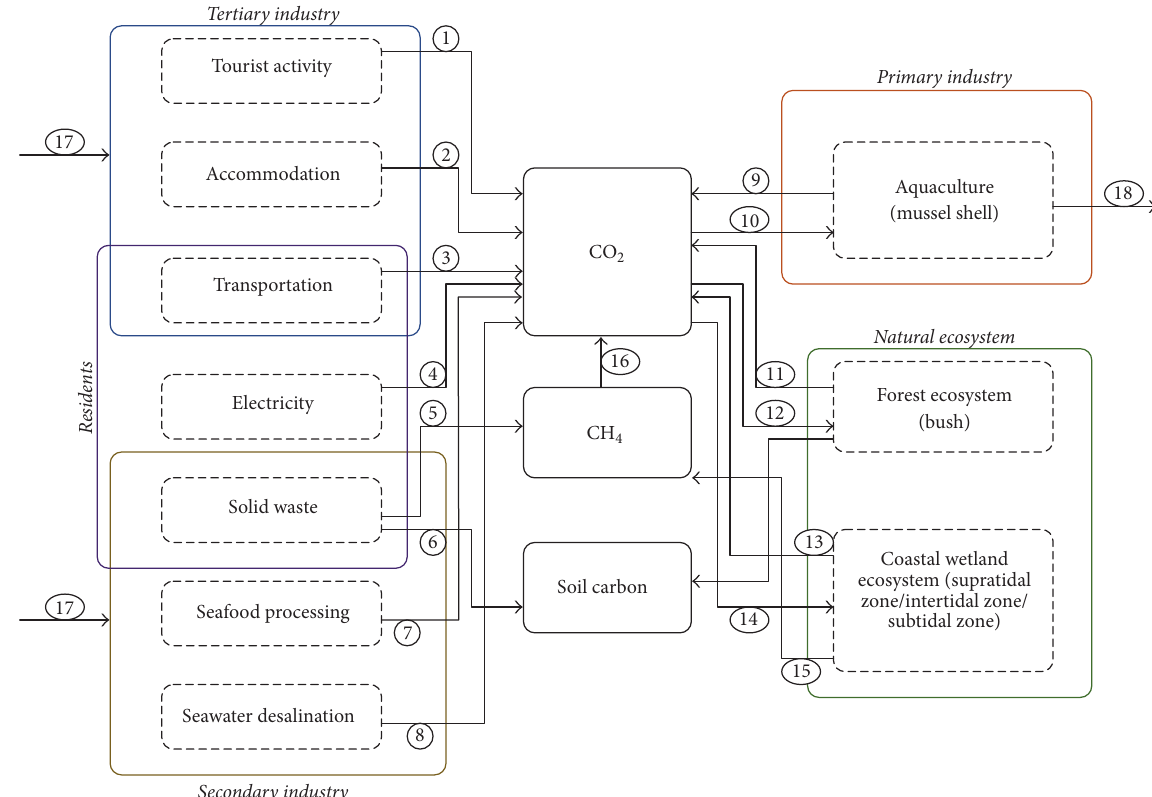
Figure 2: Conceptual model for the social-ecological process carbon cycle model on Gouqi Island. A Carbon released from tourism activity, B carbon released from tourism accommodation, C carbon released from transportation between island and outside, D carbon released of local residents, E CH 4 released from solid waste landfill, F carbon stored by soil carbon pool through solid waste landfill, G carbon released from seafood processing sector, H carbon released from desalination of seawater, 0 carbon released from marine aquaculture, 1 carbon captured by marine aqua-culturing, 2 respiration in forest ecosystem, 3 photosynthesis in forest ecosystem, 4 respiration in wetland ecosystem, 5 photosynthesis in wetland ecosystem, 6 CH 4 released from wetland ecosystem, 7 oxidation, 8 import, and 9